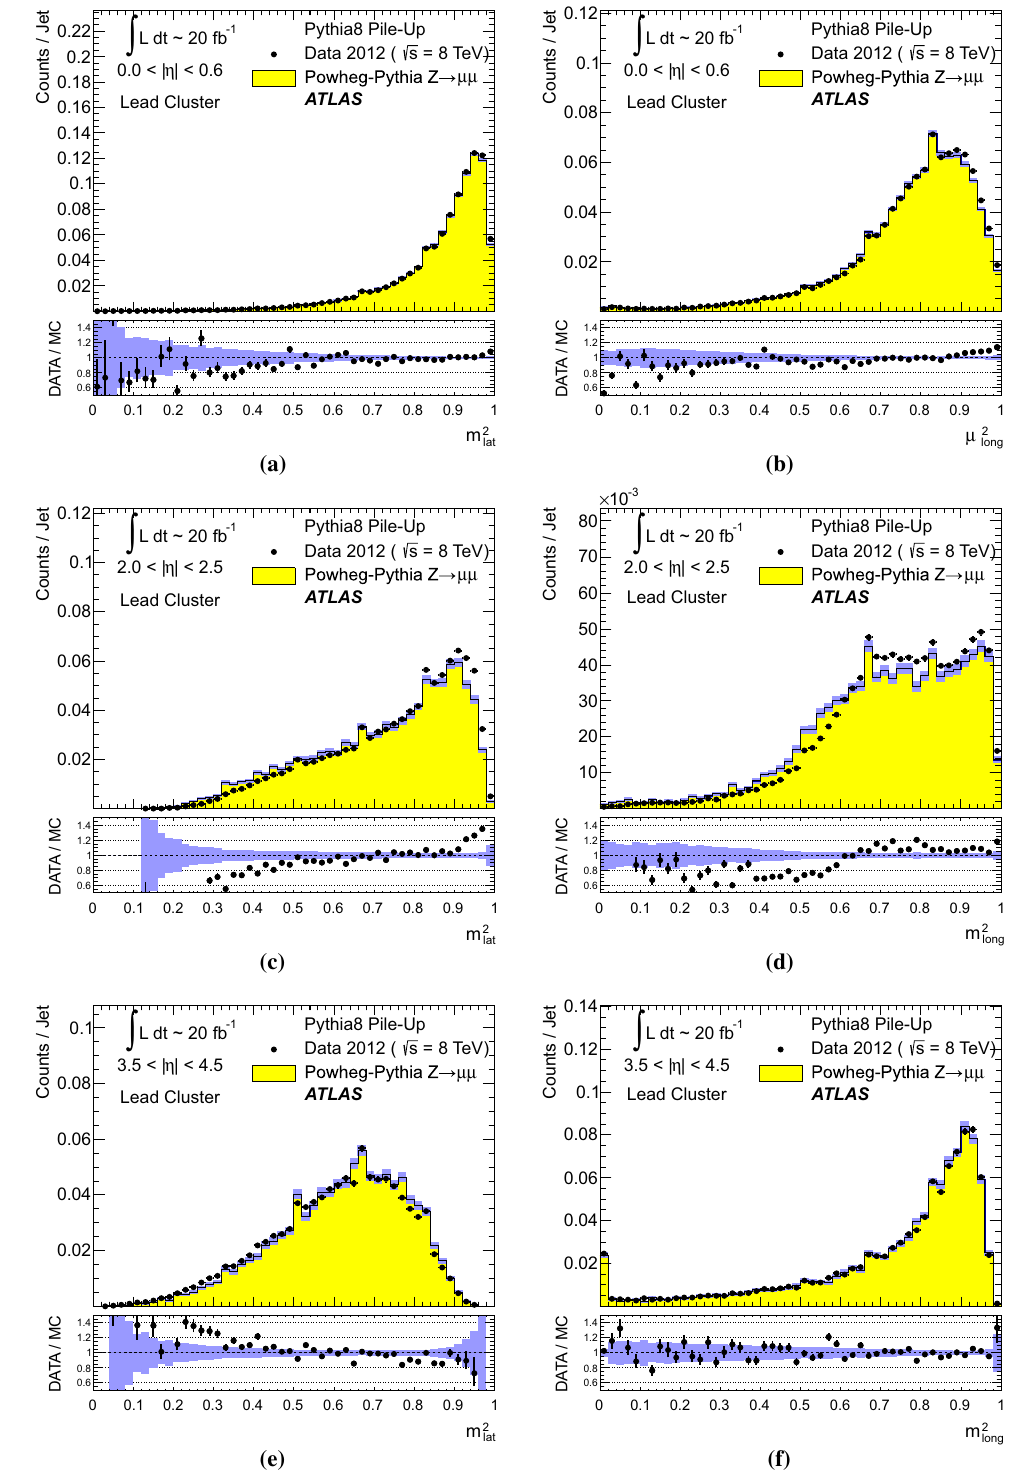
Fig. 41 The distribution of the normalised ( a , c , e ) lateral ( m 2 forward detector region (3 . 5 < | η | < 4 . 5) of ATLAS. The ratios of data ) lat and MC simulation distributions are shown below the plots. The shaded and ( b , d , f ) longitudinal ( m 2 ) extension measures of the lead- long bands shown for the distributions obtained from MC simulations indi- ing topo-cluster in fully calibrated anti- k t jets with R = 0 . 4 and < 40GeV in Z → μμ events in 2012 data cate statistical uncertainties and the corresponding uncertainty bands in 30GeV < p LCW + JES T , jet the ratio and MC simulations with fully simulated pile-up, for jets in the ( a , b ) central ( | η | < 0 . 6), the ( c , d ) end-cap (2 . 0 < | η | < 2 . 5), and the ( e , f )